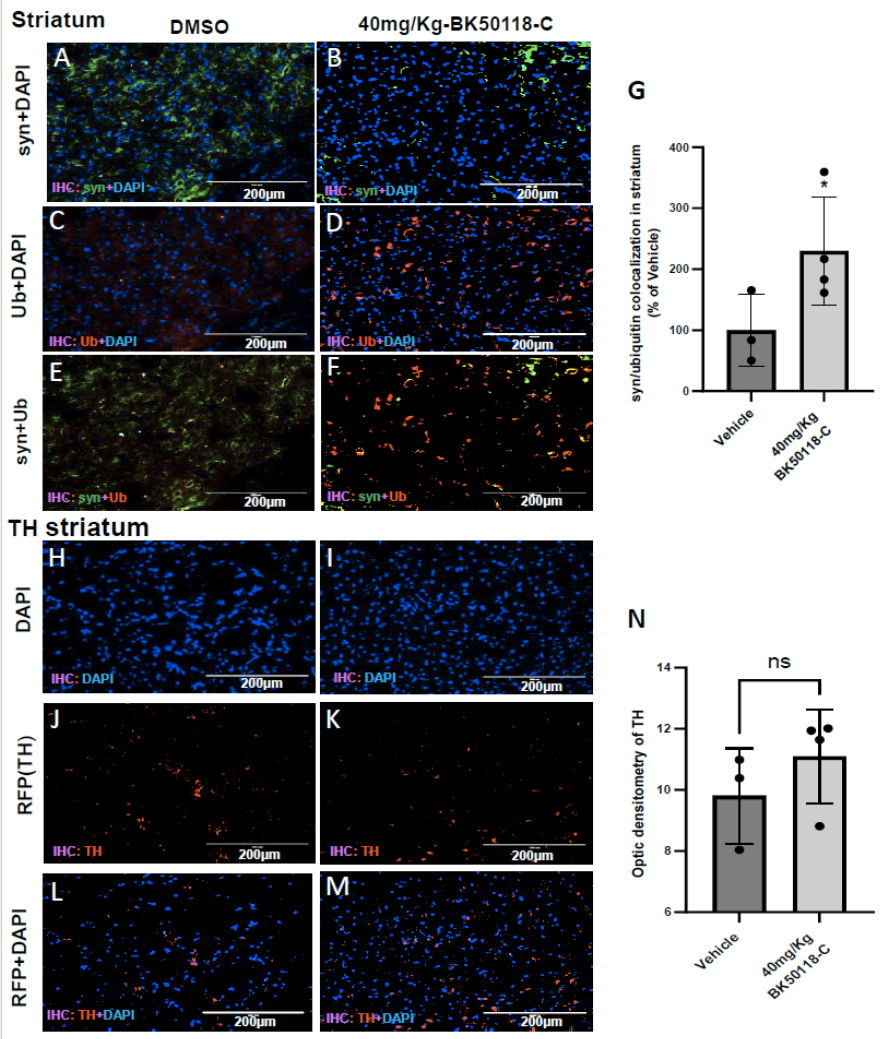
Figure 5. BK50118-C significantly increased alpha-synuclein ubiquitination but had minimal effects on tyrosine hydrox- ylase (TH) levels in striatum of TgA53T mice. Male and female TgA53T mice were treated with intraperitoneal injection of vehicle or BK50118-C at the daily dosage of 40 mg/Kg for 7 days. Immunochemistry assay of 20 µm thick brain sections showed alpha-synuclein (green), ubiquitination (red) and DAPI (blue) staining in the striatum of TgA53T mice treated with either DMSO ( A , C , E ) or BK50118-C ( B , D , F ) . BK50118-C increased alpha-synuclein ubiquitination, verified by optic density of co-localization ( G ). Immunostaining showed TH (red) and DAPI (blue) staining in vehicle DMSO ( H , J , L ) and